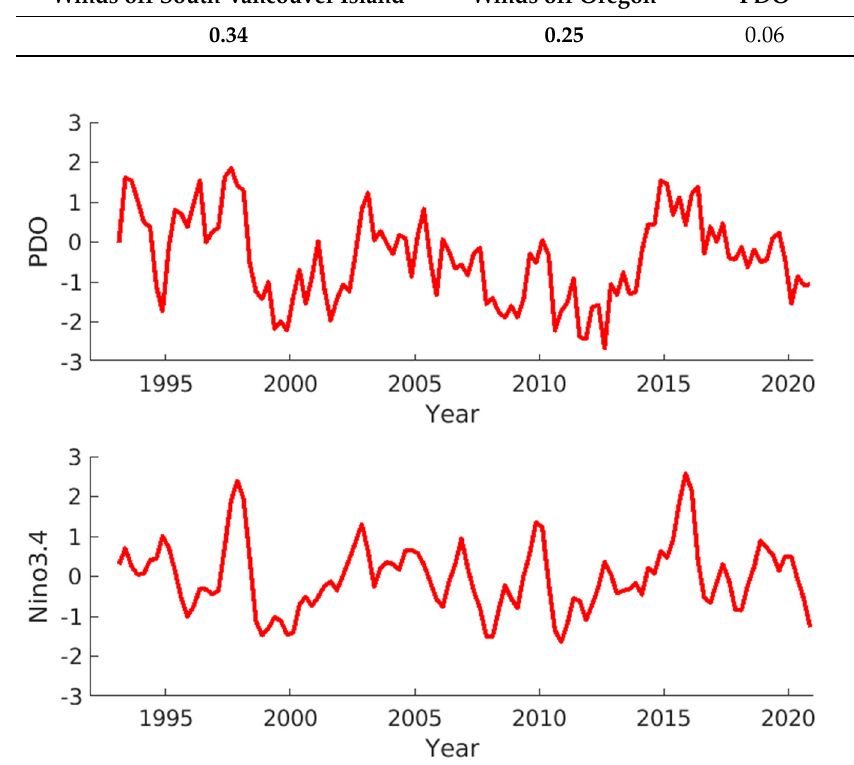
Figure 11. Seasonal PDO and Niño 3.4 indices.